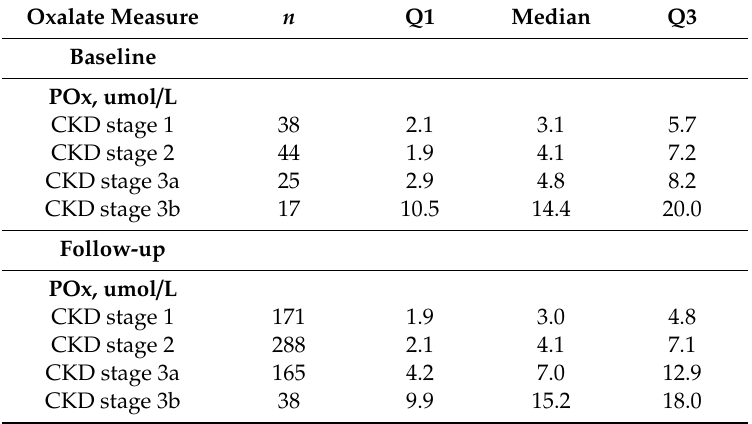
Table 2. Baseline and follow-up POx quartiles, by CKD